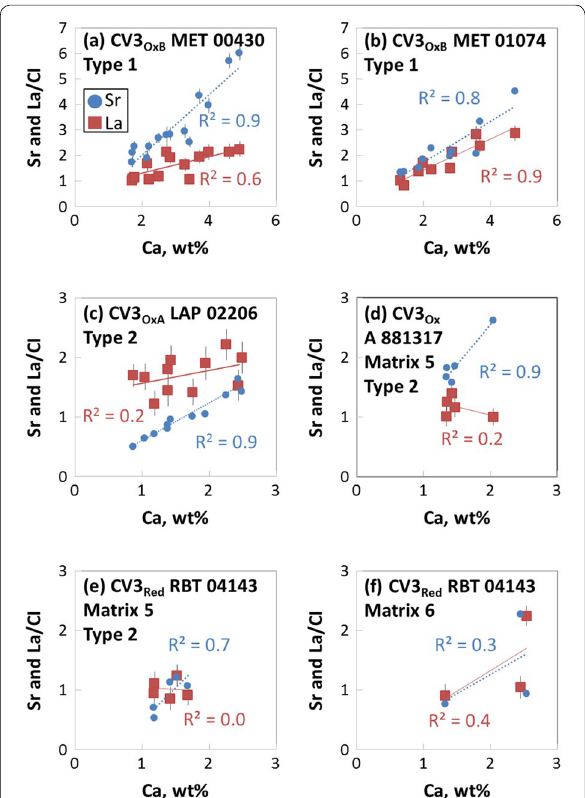
Fig. 3 Ca (wt%) versus Sr/CI (blue) and Ca/CI (red) plots of CV3 matri- ces. Error bars are 1 σ . R 2 : correlation